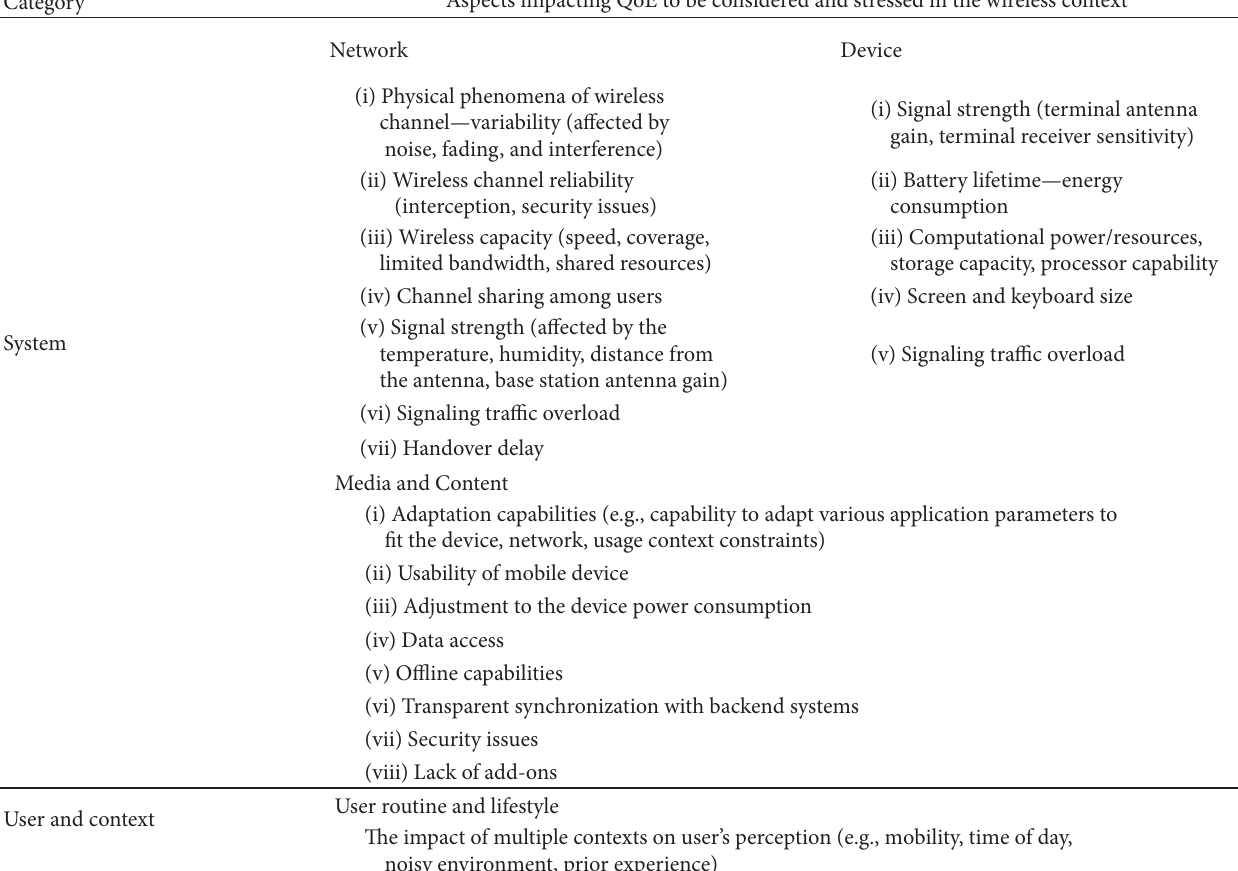
Table 2: Aspects to be considered and stressed when modeling QoE in a wireless context.